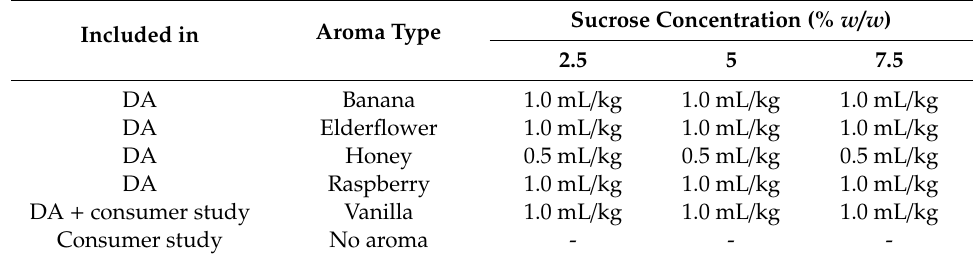
Table 1. Aroma concentrations in the samples and overview of what samples were included in each experiment. DA = descriptive analysis.